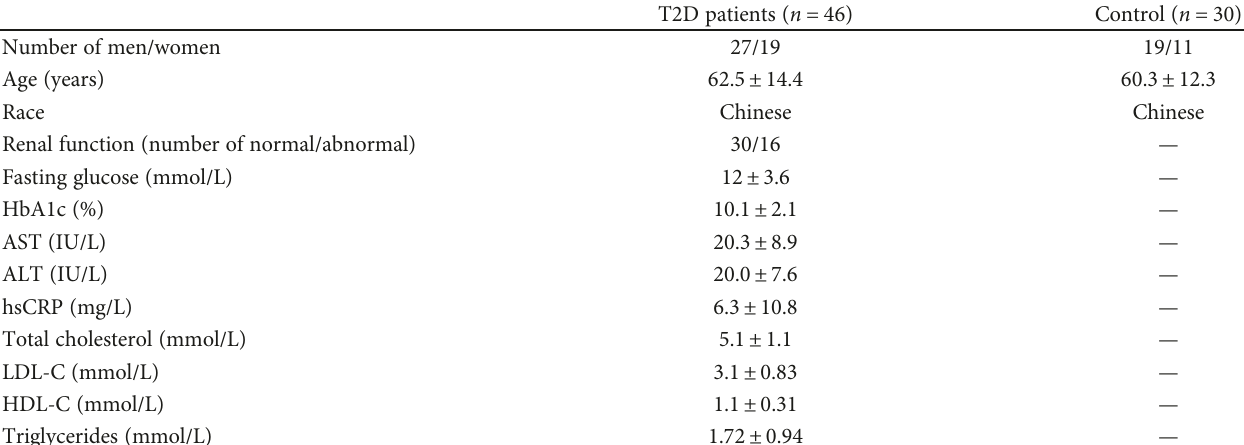
Table 1: Characteristics of type 2 diabetes patients and control